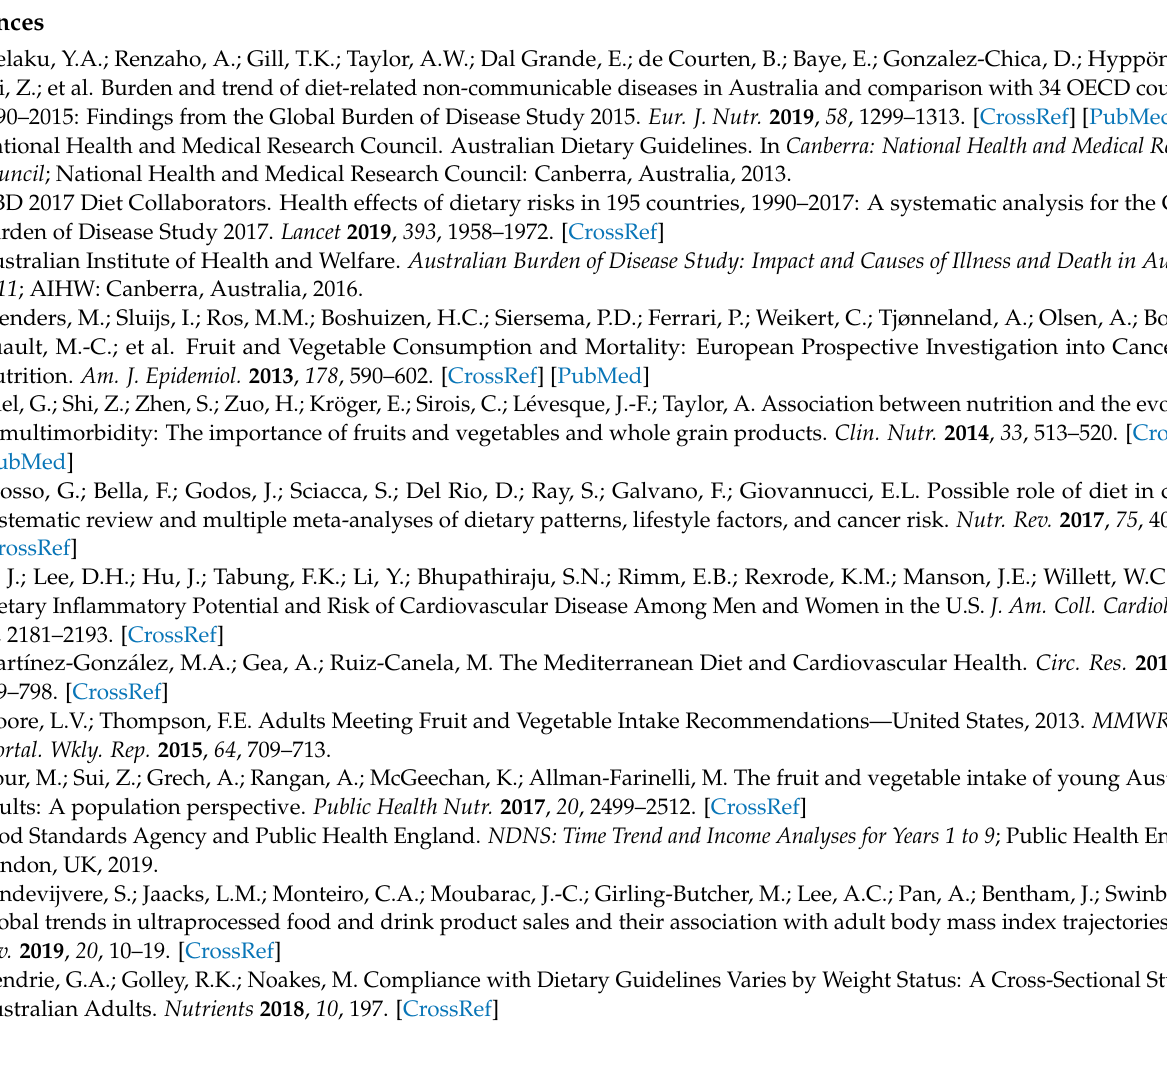
Table S2: Quality Appraisal